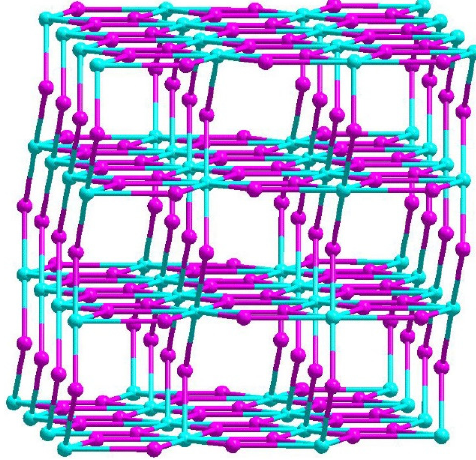
Figure 3. The topology of the compound.